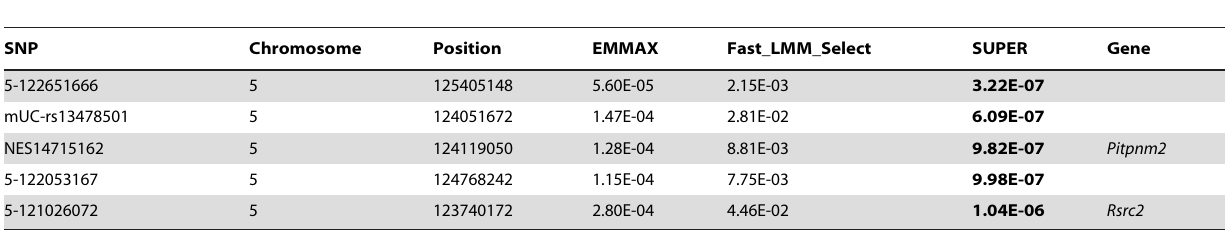
Table 2. SNPs found to be significant by SUPER and other three methods for AIL mouse data.